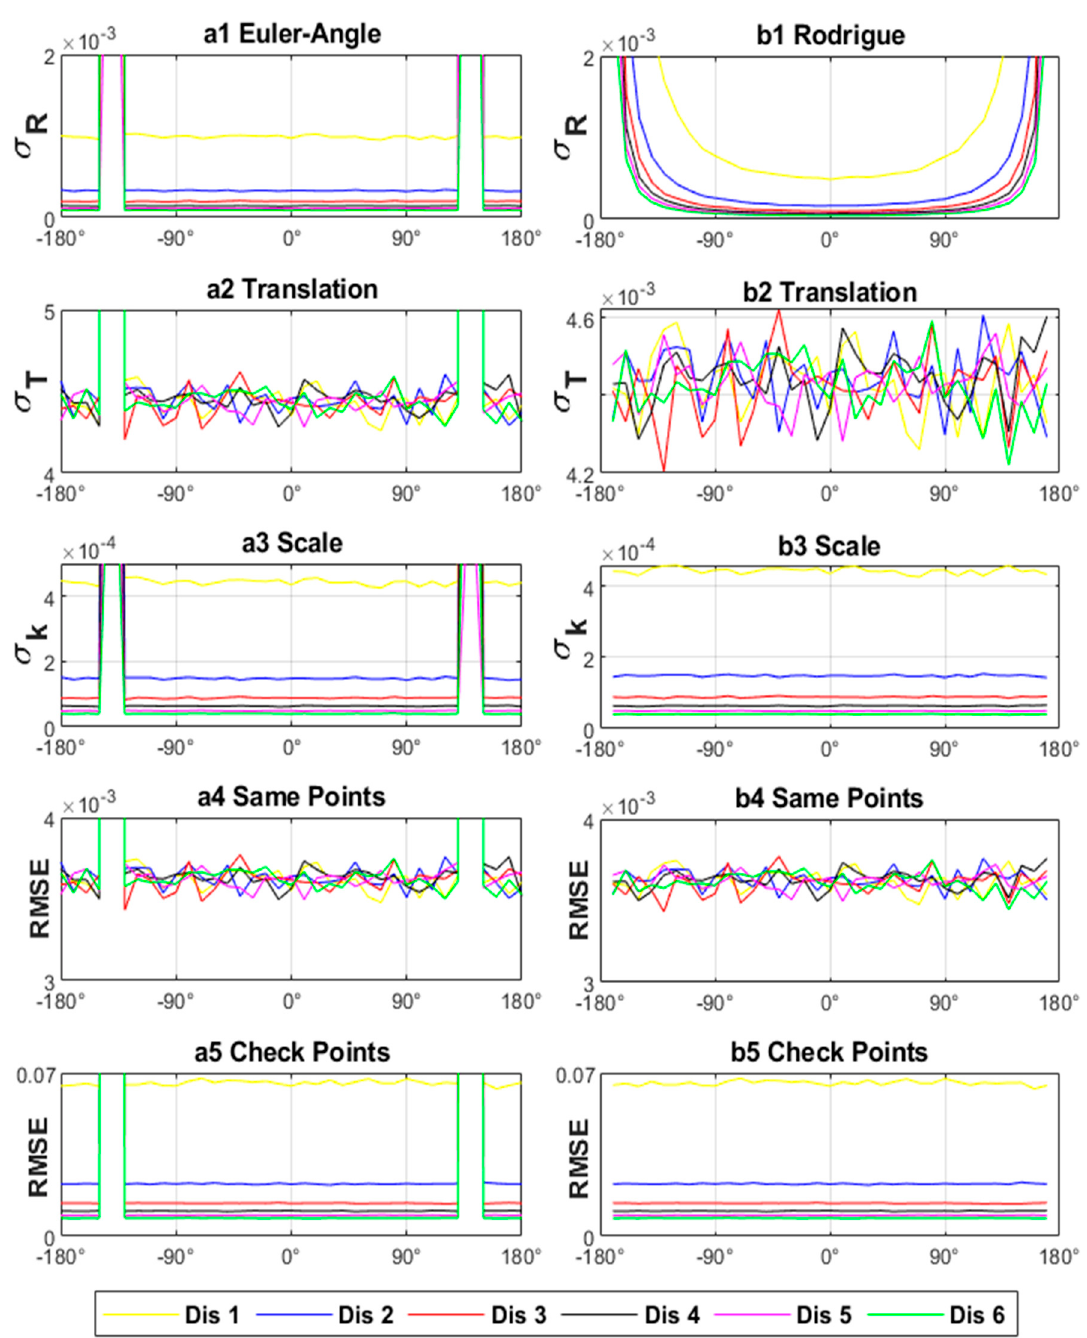
Figure 3. Transformation precision of the current transformation model for experiment II (each x axis value represents a different rotation angle, each y axis value represents a different precision for a different precision index ( a1 )- σ R (rad), ( b1 )- σ R (a.u.), σ T (m), σ k (a.u.), RMSE(m)), each color represents a different common points’ distribution, ( a1 – a5 ) shows the results of the EA-Method, ( b1 – b5 ) shows the results of the R-Method).